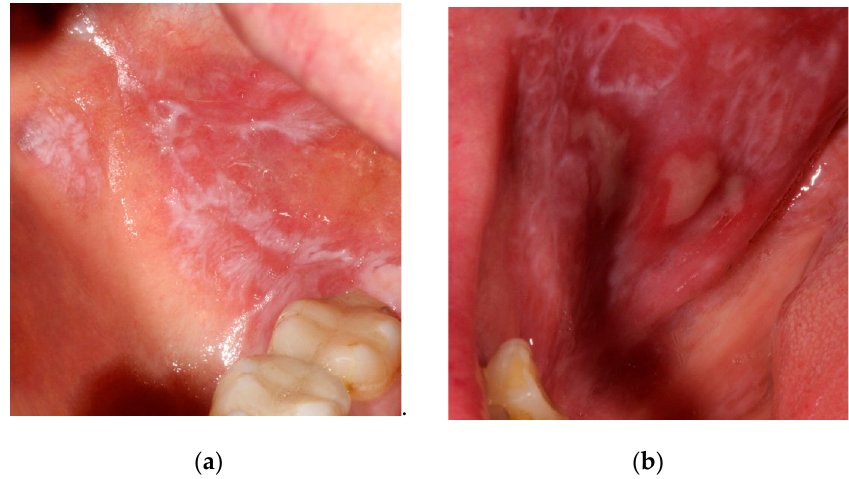
Figure 1. Lesions on buccal mucosa in patients with oral lichen planus ( a ) reticular type; ( b ) erosive part.